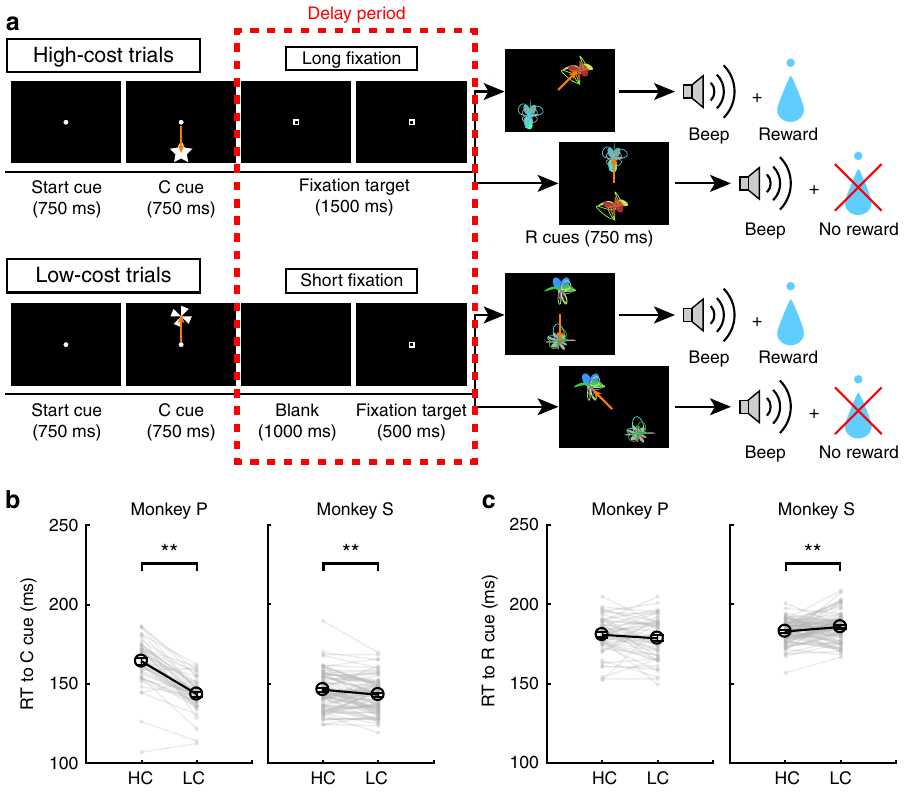
Fig. 7 HLC exploration task. a The HLC exploration task. In this task, monkeys had to choose between R + and R − cues, which were randomly generated in each learning session. If they chose the R + cue they could obtain a reward and if they chose R − cue they would not obtain reward. b RTs to the cost cues in the high-cost and low-cost trials. The monkeys showed faster RTs to the low-cost cue (** P < 0.01; two-tailed paired t test). Black circles and error bars indicate mean and SEM. c RTs to the reward cues in the high-cost and low-cost trials. Monkey S showed faster RTs to the reward cues in the high-cost